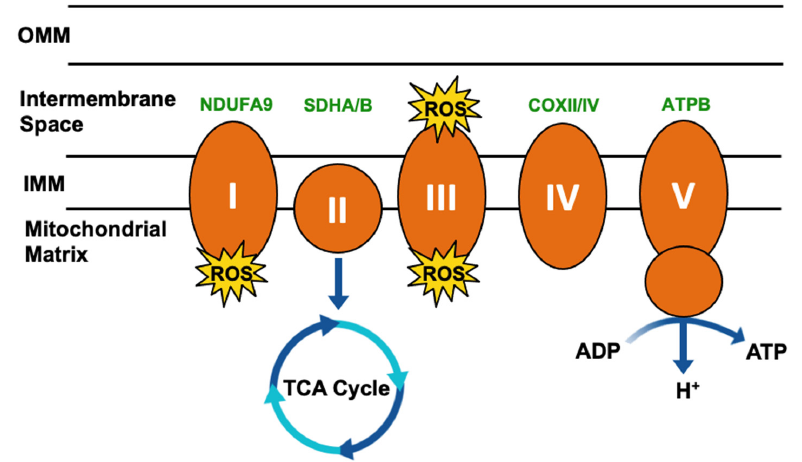
Figure 3. Simplified mitochondrial respiration schematic. Electron transport chain (ETC) complexes (I–V) are represented by orange ovals, and reactive oxygen species (ROS) generated as a byproduct of Complex I and III activity is represented by yellow starbursts. Succinate dehydrogenase (SDH)/Complex II connects the ETC to the tricarboxylic acid (TCA) cycle. TRAP1 interactors involved in this process have been highlighted in green.